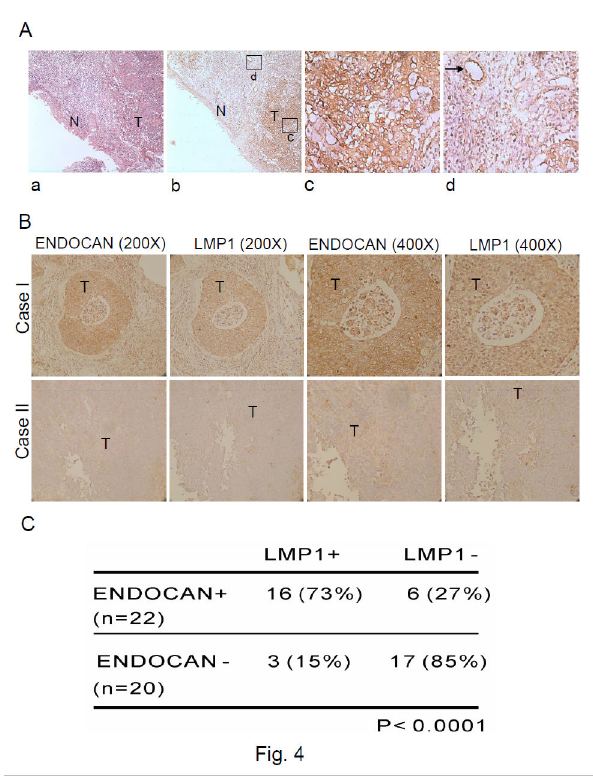
Figure 4. Endocan is overexpressed in NPC tissues and its expression is correlated with LMP1 expression. ( A ) Immunohistochemical staining of endocan in NPC tissues. Panel a, H&E staining (original magnification, ×100). Panel b, Endocan was expressed in NPC tumor cells but not in adjacent normal epithelial cells (original magnification, ×100). Panel c, The tumor part (marked as square c) in Panel b was photographed at higher magnification (original magnification, ×400). Panel d, Square d in Panel b was photographed at higher magnification (original magnification, ×400). Endocan expression was found in vascular endothelial cells adjacent to the tumor. Arrowhead indicates vascular endothelial cells. T, tumor cells; N, normal epithelial cells. The brown color represents endocan staining. ( B ) Immunohistochemical staining of endocan and LMP1 in NPC tissues. Case I shows the representative result with high endocan and LMP1 expression in consecutive sections. Case II shows the representative result with negative staining of endocan and LMP1 in consecutive sections. The brown color represents endocan or LMP1 staining. T, tumor cells. ( C ) Association between endocan and LMP1 protein expressions in 42 NPC cases. Statistical relationships between endocan and LMP1 expressions were analyzed by χ 2 test.